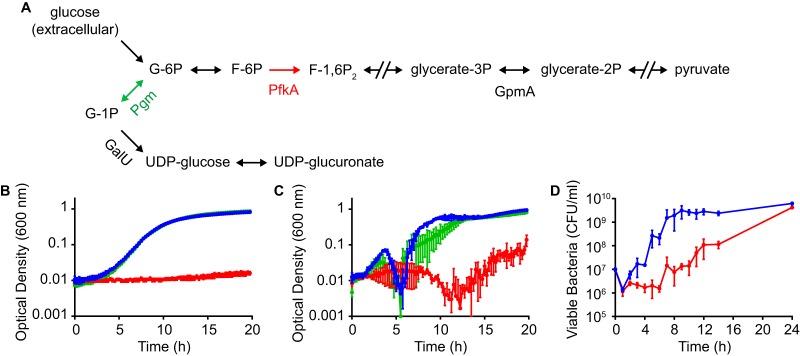
S. marcescens fitness genes involved in glucose metabolism and growth in serum. (A) Predicted enzymatic pathways for the conversion of glucose into pyruvate and UDP-glucuronate by S. marcescens. Gene products that contribute to S. marcescens fitness during bloodstream infection as determined by INSeq are indicated. Broken arrows represent multiple steps in product and substrate interconversion that are not shown. Abbreviations: G-1P, glucose-1-phosphate; G-6P, glucose-6-phosphate; F-6P, fructose-6-phosphate; F-1,6P2, fructose-1,6-bisphosphate. (B) Growth of S. marcescens strains in M9 medium supplemented with 0.4% glucose as the sole carbon source. (C) Growth of S. marcescens strains in M9 medium supplemented with 20% HI normal human serum. (D) Growth of S. marcescens in M9 with serum as determined by viable counts. Reported values are the mean of triplicate cultures ± the standard deviation. The S. marcescens strains tested were wild-type UMH9 (blue) and pfkA (red) and pgm (green) mutants.